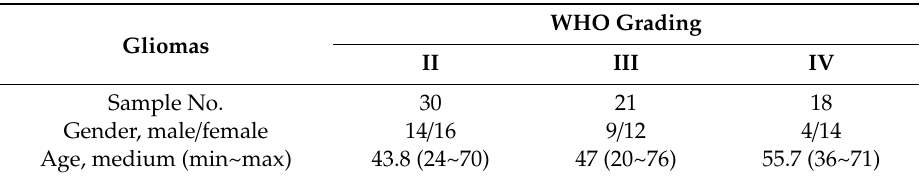
Table 1. Clinical characteristics of the glioma patients for glioma grading study. WHO Grading Gliomas II III IV Sample No.